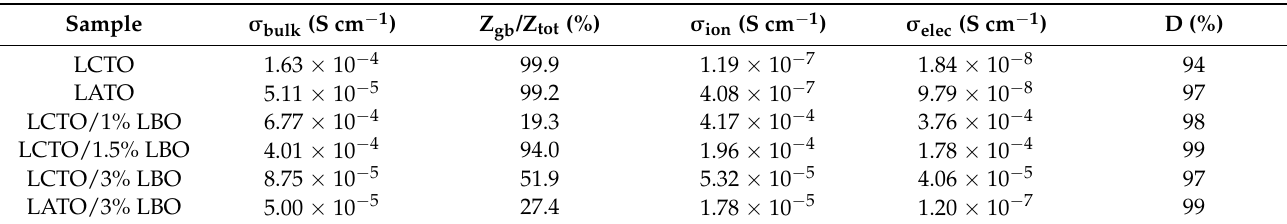
Table 1. Average room temperature (298 K) bulk ionic, σ bulk , grain boundary ionic impedance as percentage of total impedance, Z gb /Z tot , total ionic conductivity, σ ion , electronic conductivity, σ elec and relative density, D, of Li 1.25 CrTi 1.5 O 4 (LCTO) and Li 1.25 Al 0.25 Ti 1.5 O 4 (LATO) solid electrolytes with and without Li 3 BO 3 (LBO) sintering aid.